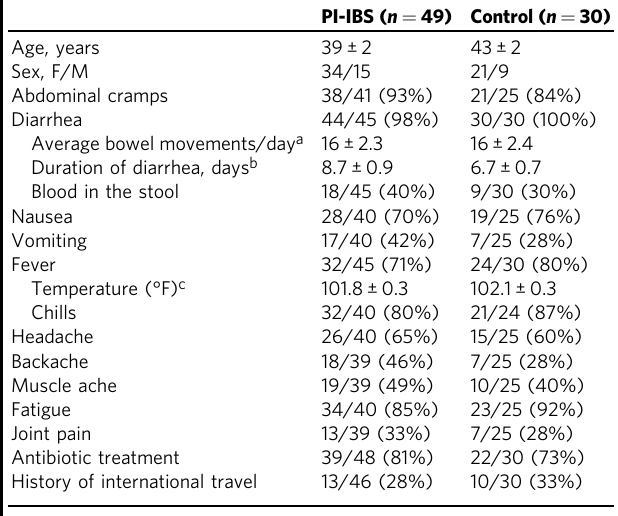
Table 1 Demographic and clinical characteristics of